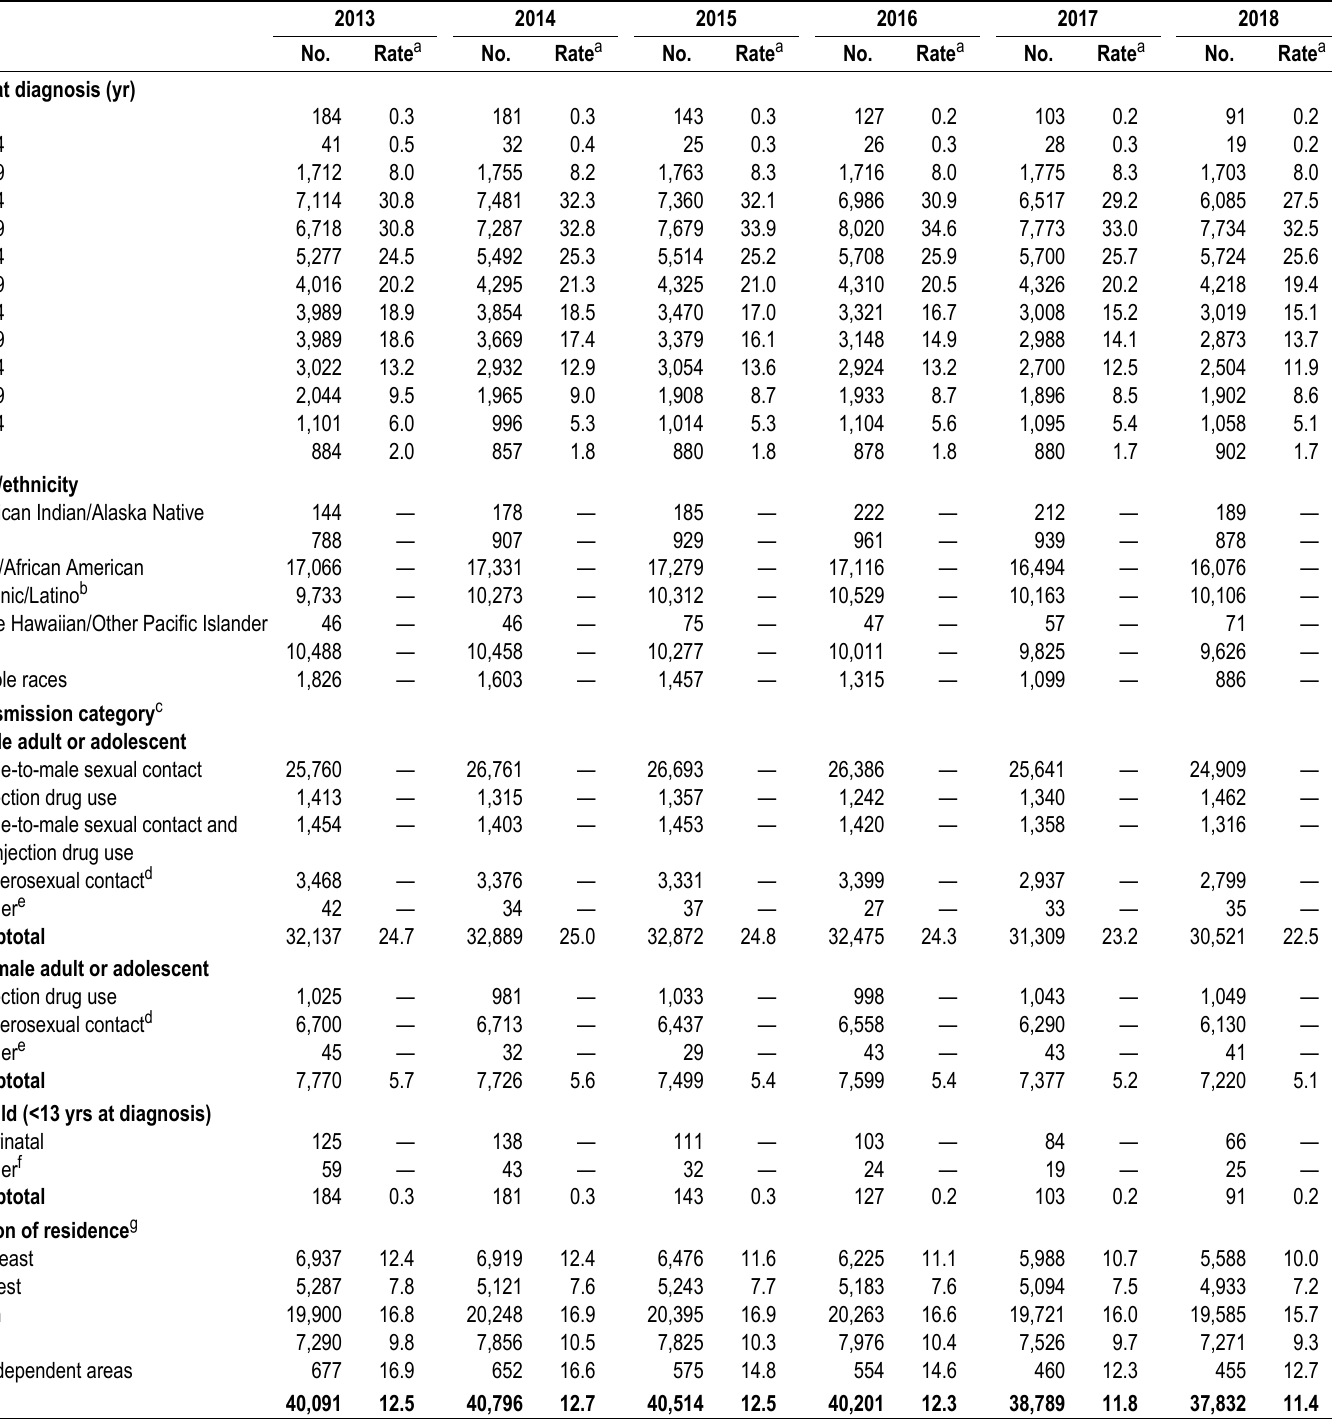
Table 1b. Diagnoses of HIV infection, by year of diagnosis and selected characteristics, 2013–2018—United States and 6 dependent